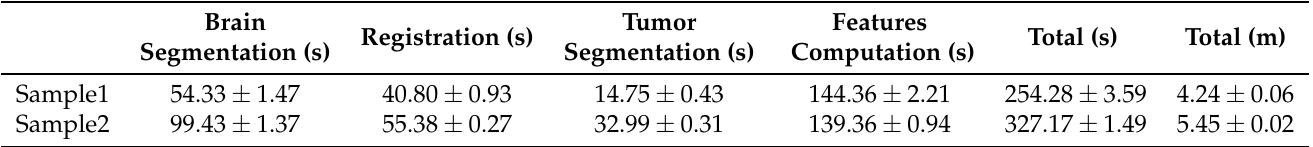
Table 6. Speed performances for the segmentation, feature extraction, and overall standardized report generation. Results were averaged after 10 consecutive runs over two representative MRI volumes, using CPU support only.